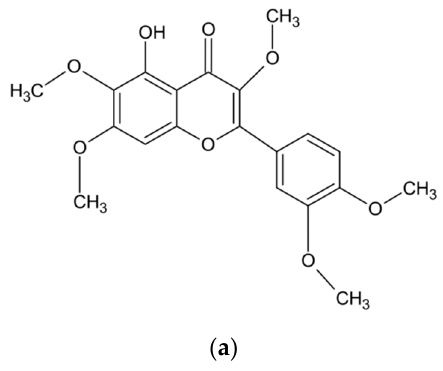
Figure 1. Chemical structure of the dominant compounds in A. abrotanum essential oil: ( a ) borneol; ( b ) camphor; ( c ) trans -sabinyl acetate; ( d ) 1,8-cineole; ( e ) piperitone; ( f ) davanone.